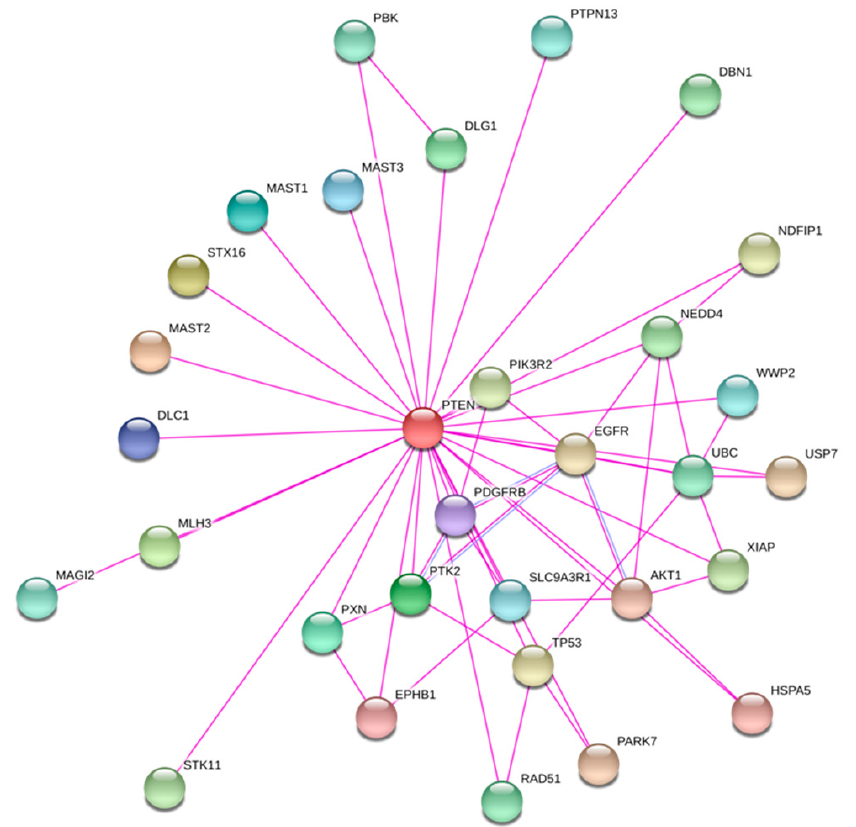
Figure 1. Interacting partners of PTEN. Protein interaction network of 30 representative interaction partners of PTEN (red dot) based on experimental evidence. Data downloaded from STRING functional protein association networks database (https://string-db.org).